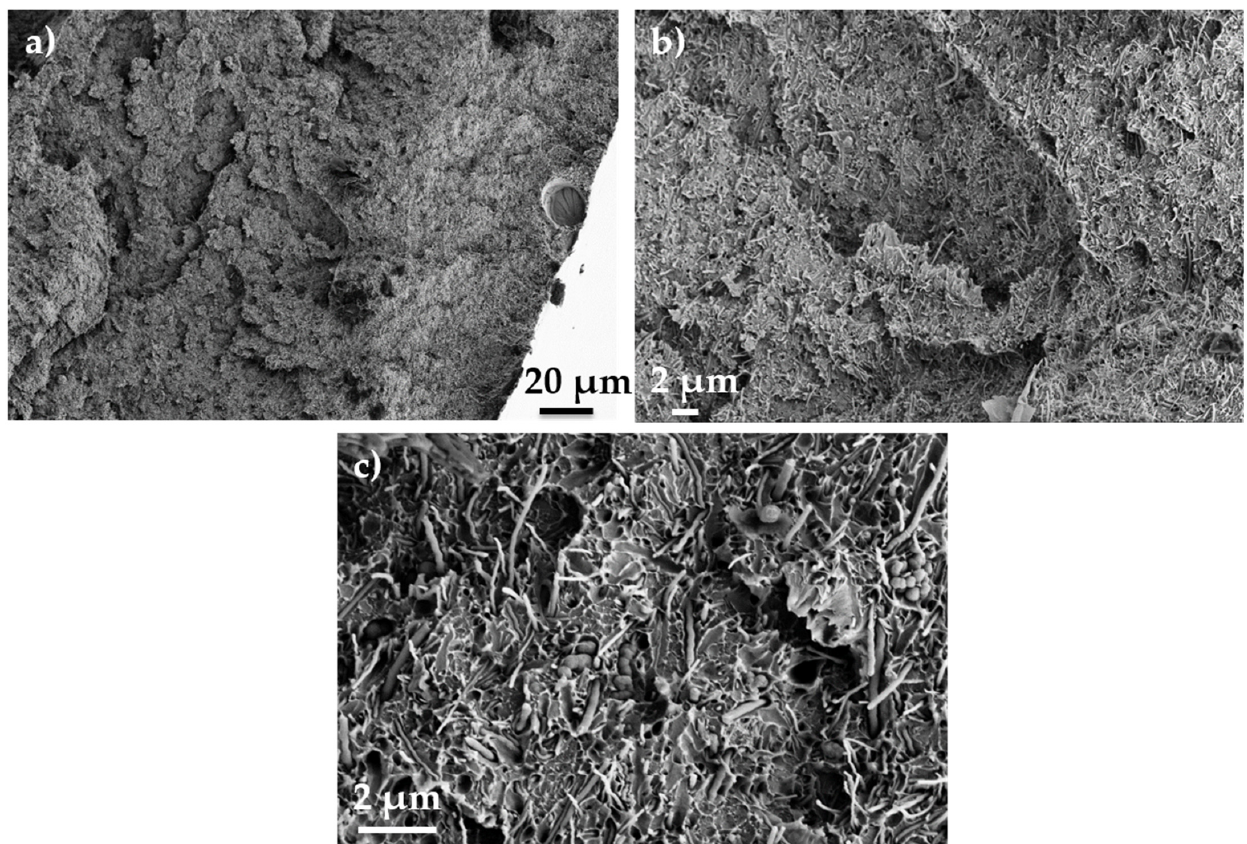
Figure 3. SEM micrographs of the PEEK/10 wt. % CNF composite at ( a ) lower, and ( b , c ) higher magnifications.